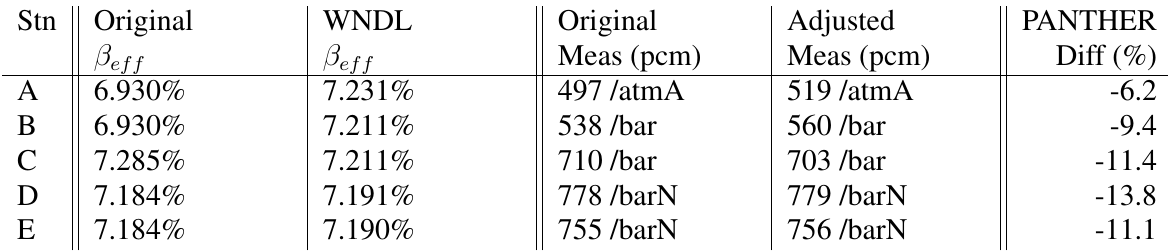
Table I: Pressure Coefficient Measurements Analysed with WNDL Kinetic Data.